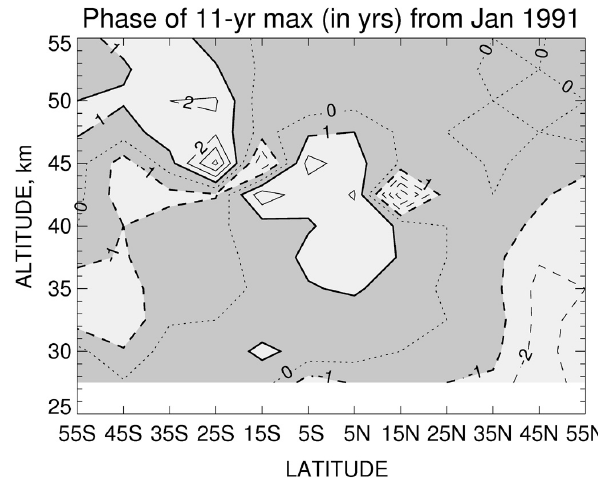
Fig. 9. As in Fig. 6, but the max minus min variations are from the SAGE II data from September 1992 through August 2005.